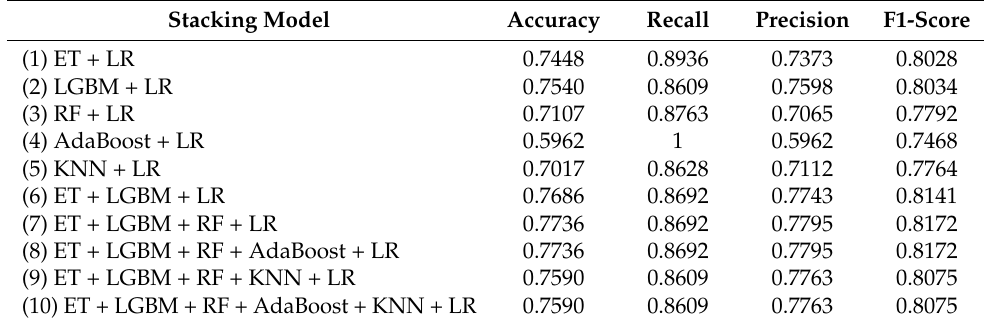
Table 4. Performance of 10 stacking models.